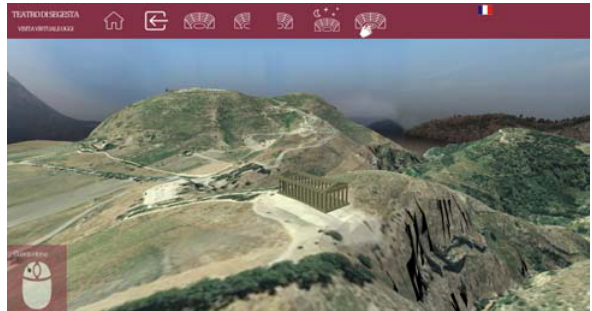
Figure 7. Archaeological park of Segesta (virtual reality view)